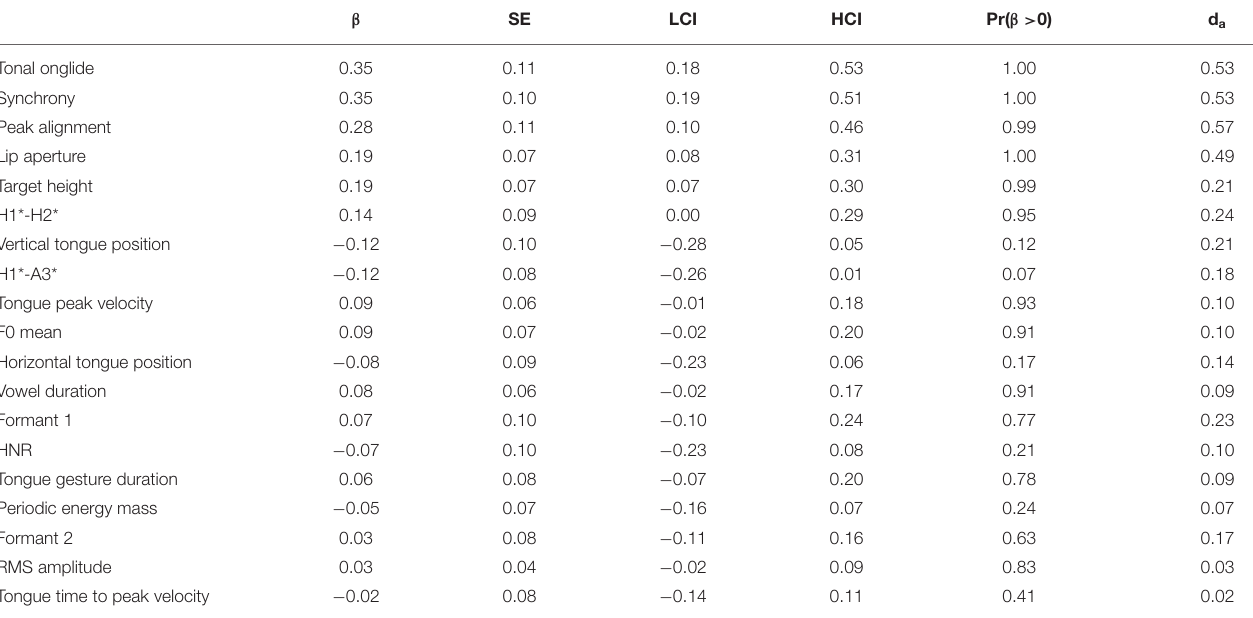
TABLE 9 | Tabular overview of modeling results for narrow versus contrastive focus, vowel /a/. LCI and HCI refer to the low and high boundaries of the 90% Credible